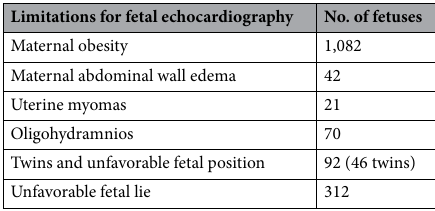
Table 1. Limitations for fetal